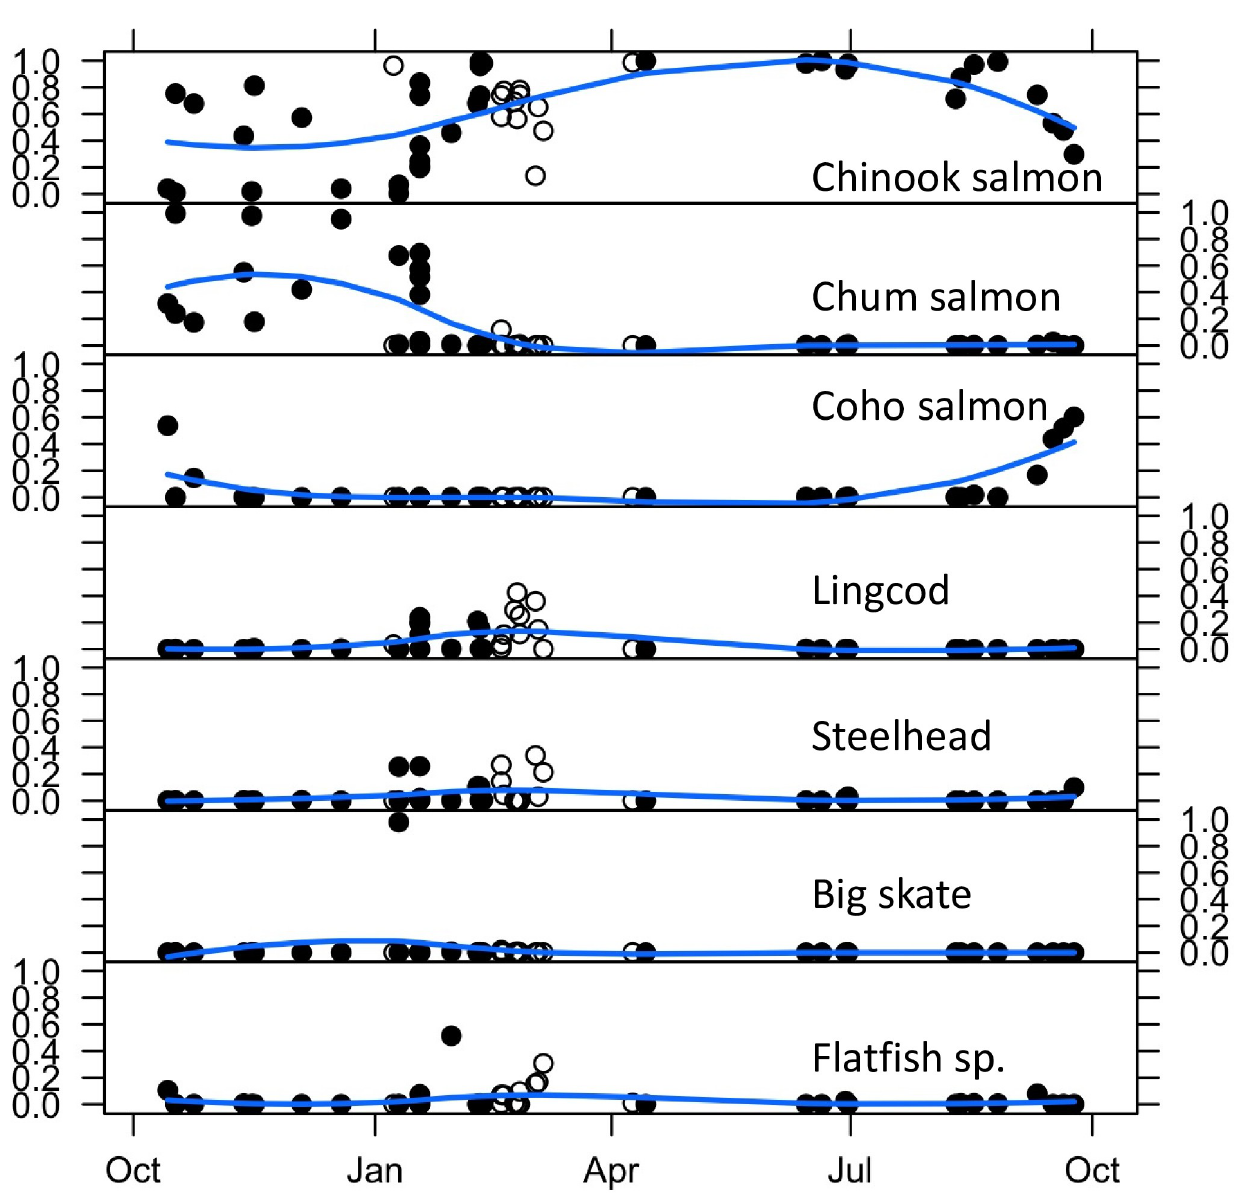
Fig 4. Seasonal proportion of sequences assigned to seven Southern Resident killer whale prey species (or groups of species) across all fecal samples. Open and filled symbols indicate samples from the outer coast and Salish Sea, respectively. Lines indicate predicted values from local polynomial regression. Data from May—September are from